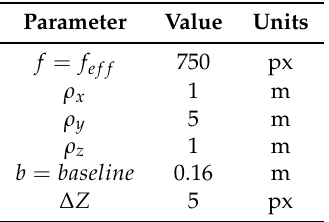
Table 1. Simulation parameter values.